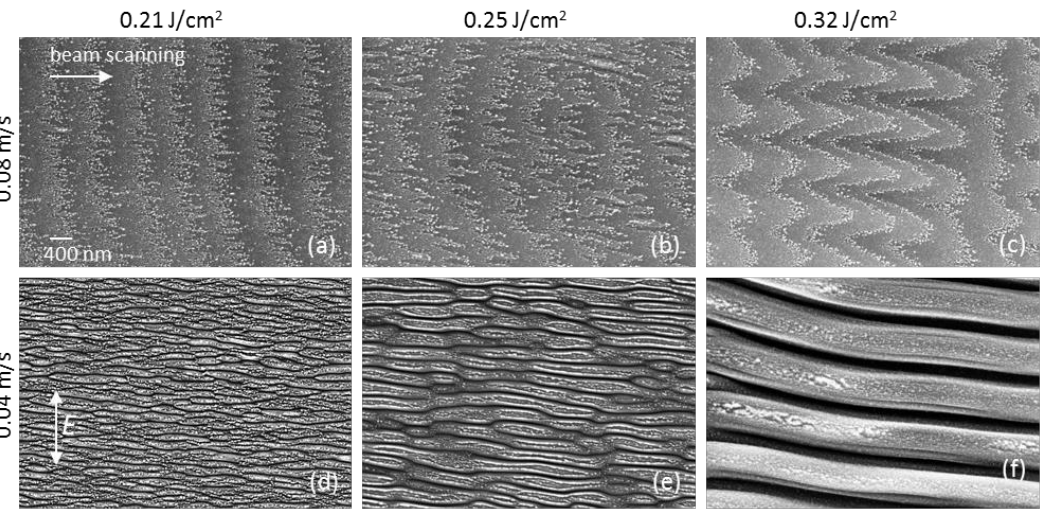
Figure 2. Changes in the surface morphology in central regions of the microgrooves on the DLN film with increasing fluence (0.21 J/cm 2 , 0.25 J/cm 2 , and 0.32 J/cm 2 ) at two scanning velocities of 0.08 m/s ( a – c ) and 0.04 m/s ( d – f ); the beam polarization direction is perpendicular to the scanning direction.